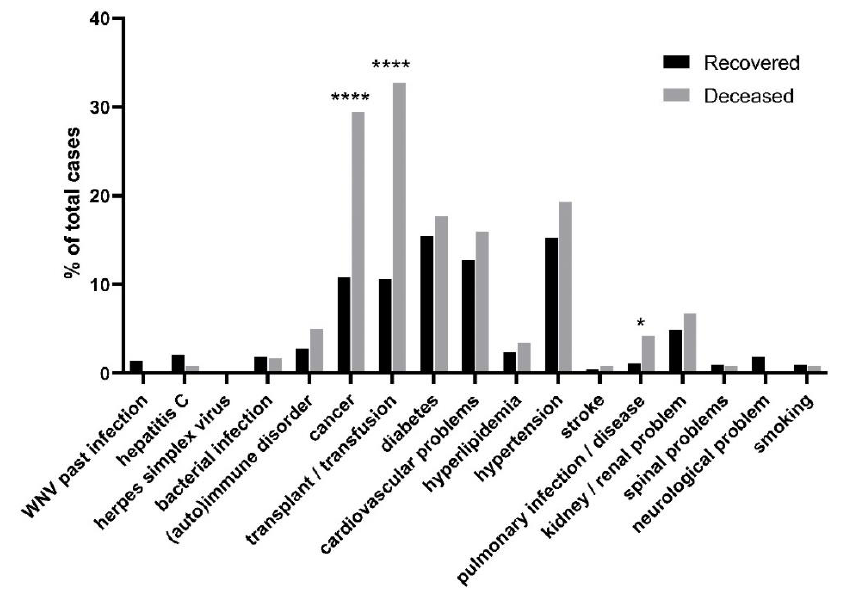
Figure 4. Rates of occurrence for the majority of comorbidities related to WNV infection between patients that recovered and those that deceased. Significant differences for each comorbidity between the recovered and deceased groups of patients were assessed by a two-tailed t -test (two-sample assuming equal variances) and are indicated by (* p < 0.05, and **** p < 0.0001).